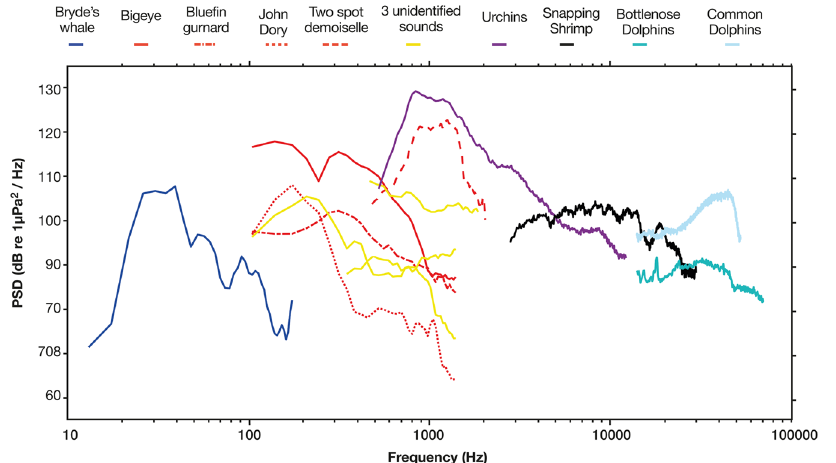
Figure 4. Power spectral density (dB re 1 µ Pa 2 Hz − 1 ) for the best example of nine different biological sounds manually identified from recordings taken throughout the Hauraki